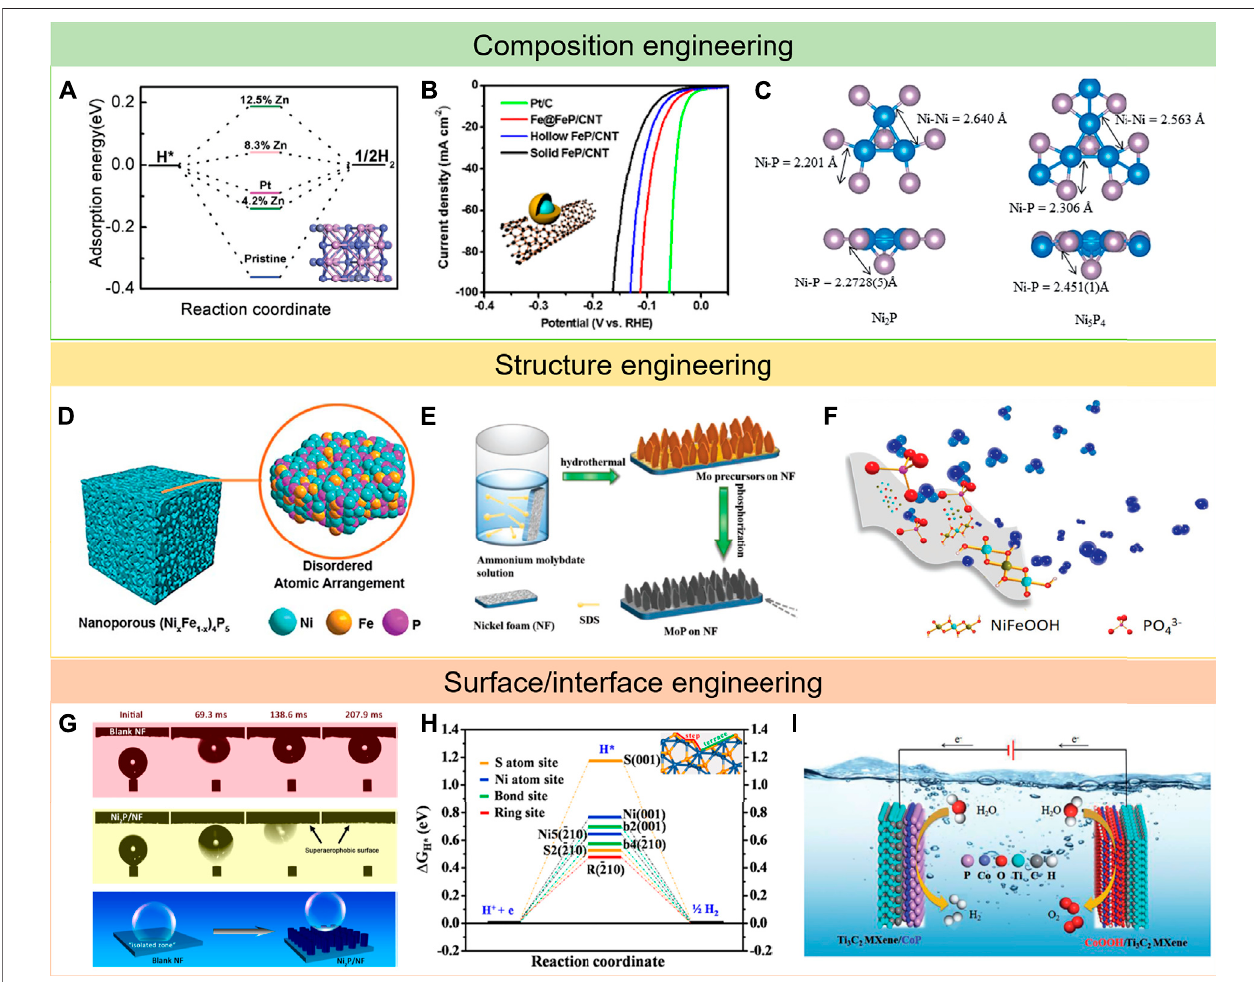
FIGURE 2 | Typical examples of strategies for the development of TMP electrocatalysts: (A – C) composition engineering, reproduced with permission from ref. Liu etal.(2017),Lietal.(2017),andLaursenetal.(2015),respectively; (D – F) structureengineering,reproducedwithpermissionfromref.Xuetal.(2018a),Jiangetal.(2018), andHuetal.(2017),respectively;and (G – I) surface/interfaceengineering,reproducedwithpermissionfromref.(Yuetal.(2019b),Fengetal.(2015),andYanetal.(2020), respectively.